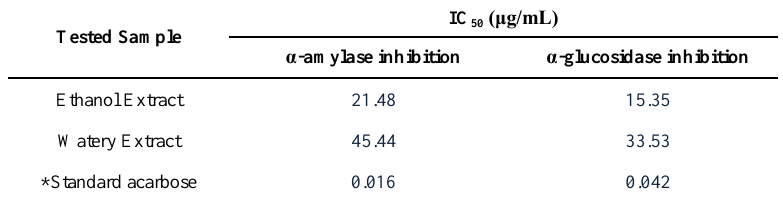
Table 5. Antidiabetic activities of ethanol and watery extracts of the stem barks of Phyllanthus